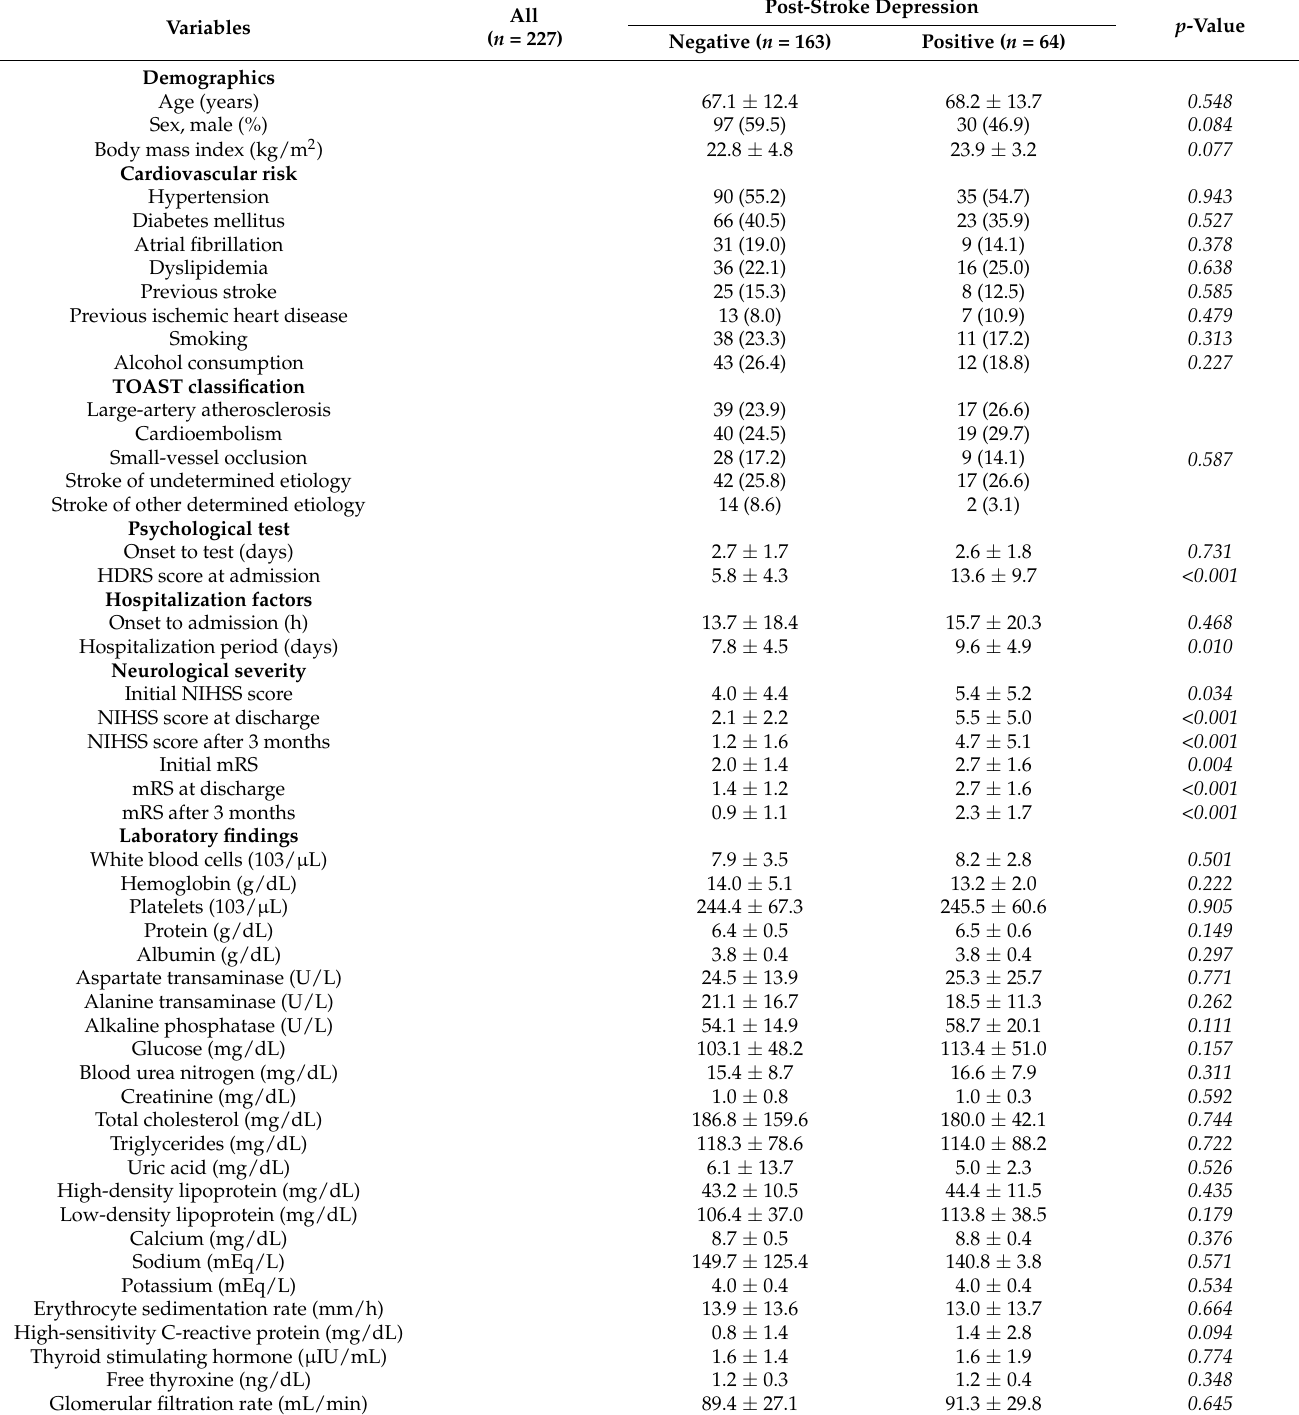
Table 1. Baseline Characteristics of the Study